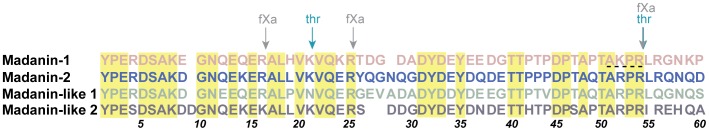
Sequence alignment of MEROPS family I53 inhibitors from the bush tick Haemaphysalis longicornis.Alignment of the amino acid sequences of the mature forms of madanin-1 (UniProt entry Q86FP9_HAELO) and madanin-2 (Q86FP8_HAELO), and of the putative mature madanin-like protein 1 (Q4R1A5_HAELO) and madanin-like protein 2 (Q4R1A2_HAELO). Strictly conserved residues are highlighted in yellow. The numbering for mature madanin-1 is given below the alignment. Thrombin (teal) and factor Xa (grey) cleavage sites are indicated. The dashed line highlights the four residues of madanin-1 modeled in the experimental three-dimensional structure of the thrombin·madanin complex.